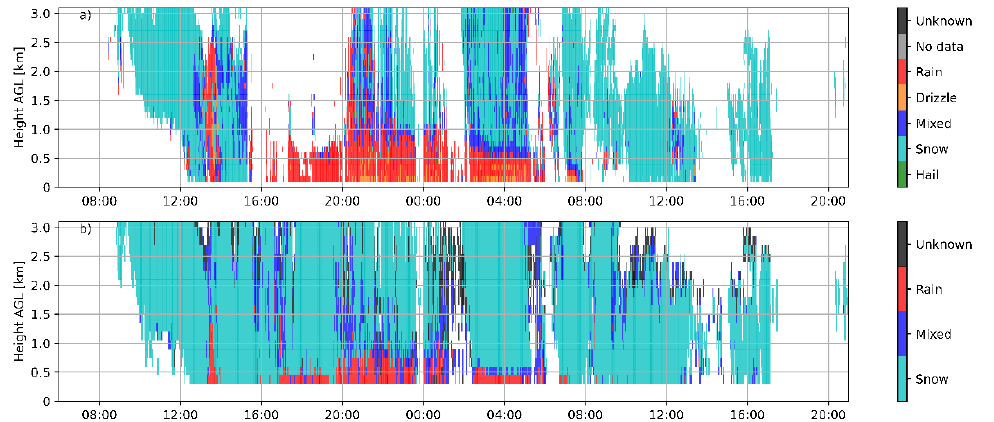
Figure 9. Precipitation type estimation during the 24 and 25 March 2017 event. ( a ) MRR2 observations with 6 classes and ( b ) RWP Method2, using A73, with 5 classes. Note RWP data has been clipped to the MRR2 maximum height. White areas indicate clear air echoes.